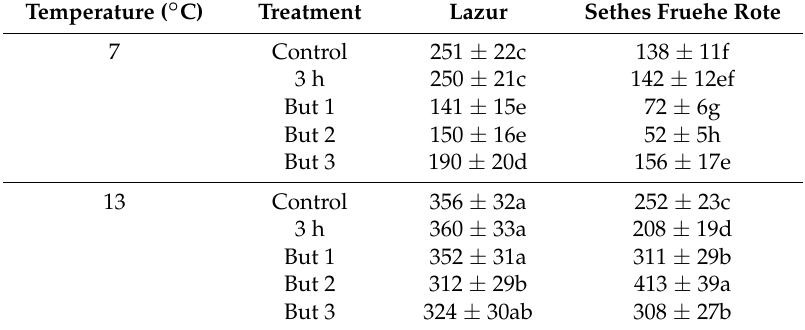
Table 3. Effects of pre-sowing treatments on the index of vegetative phase development (VPDi) of two L. angustifolius cultivars germinated and grown for the first four weeks at 7 ◦ C or 13 ◦ C. Control—plants grown from seeds germinated in water; 3 h—plants grown from seeds hydroprimed for 3 h at 20 ◦ C; But 1, But 2, But 3—plants grown form seeds germinated in the presence of 10 − 6 M, 10 − 5 M, 10 − 4 M butenolide,